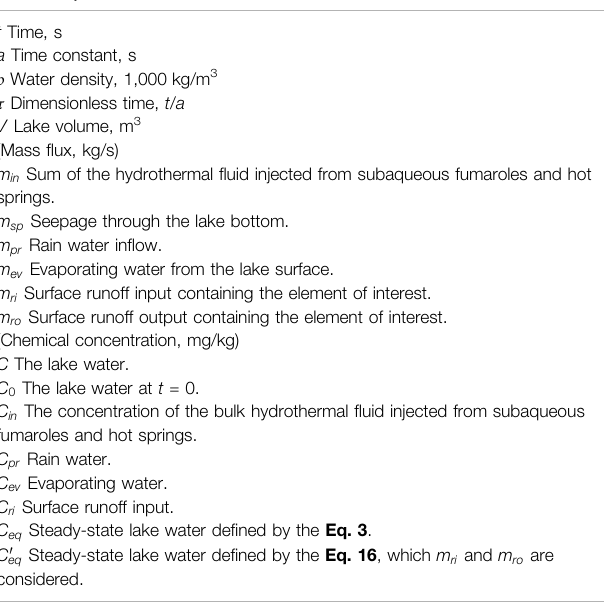
TABLE 1 | De fi nitions of